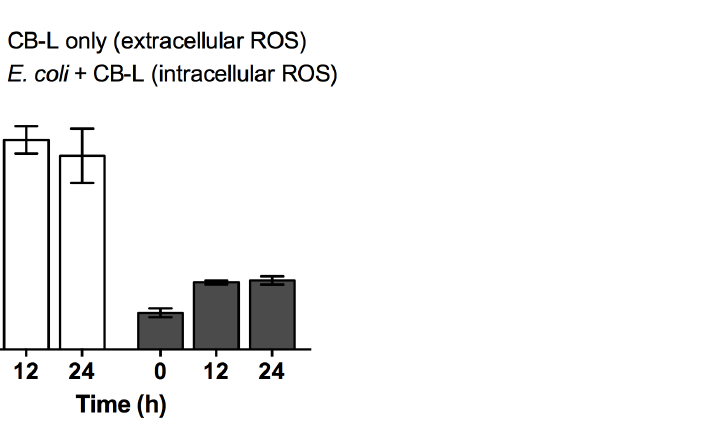
Fig. 4. CB-L-associated ROS production in the absence and presence of E. coli ATCC 25922. ROS was measured in CB-L without the presence of cells (extracellular; using a plate reader) and exclusively in the intracellular environment of exponential-phase E. coli following CB-L exposure (intracellular; using flow cytometry). Cells were grown overnight, transferred to fresh growth media and grown to mid-logarithmic phase, washed, and exposed to CB-L for 24 h. Reported values represent the ROS production fold change of CB-L compared to water and CB-L-exposed cells compared to water-exposed cells. Data are presented as the mean ¡ standard error of the mean (SEM) for three independent